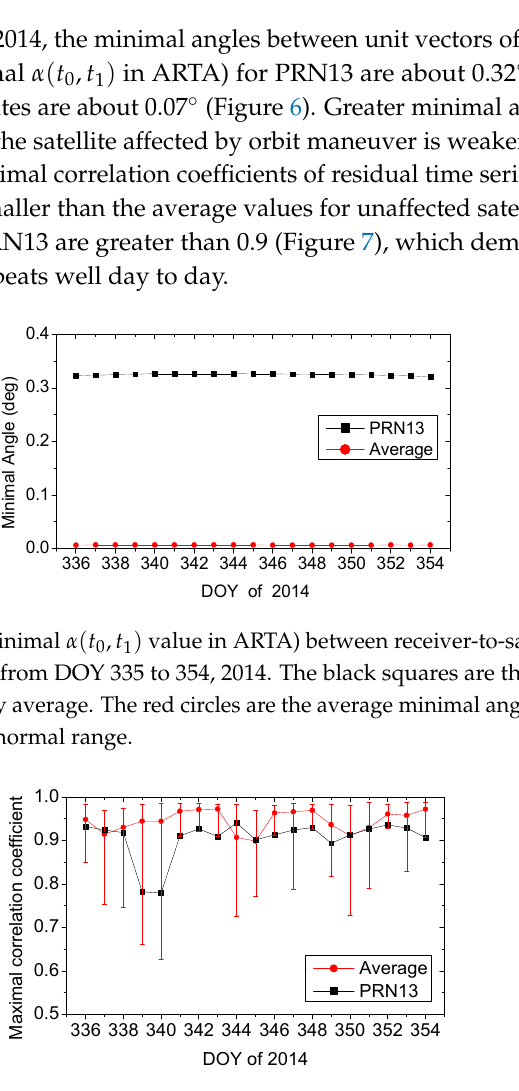
Figure 5. ORTM-, ARTA-, and RCM-derived MRT estimates for PRN13. The y -axis shows the daily advance time. MRT estimate equals 86,400 s minus daily advance time.